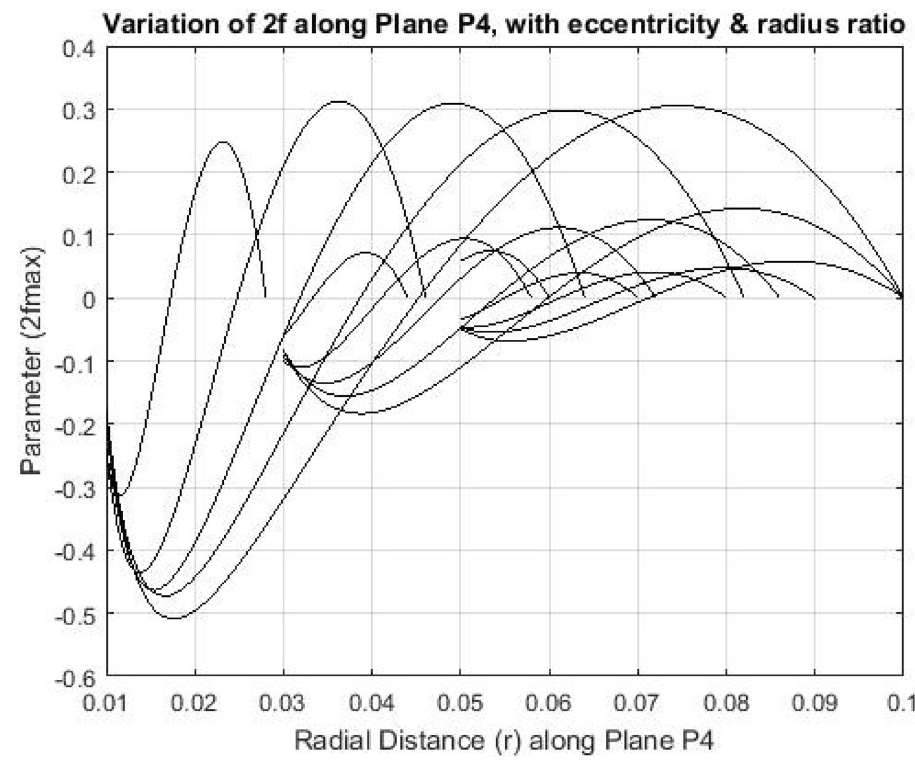
Fig. 6 Variation of the 2f value with respect to r , k and ɛ along plane P